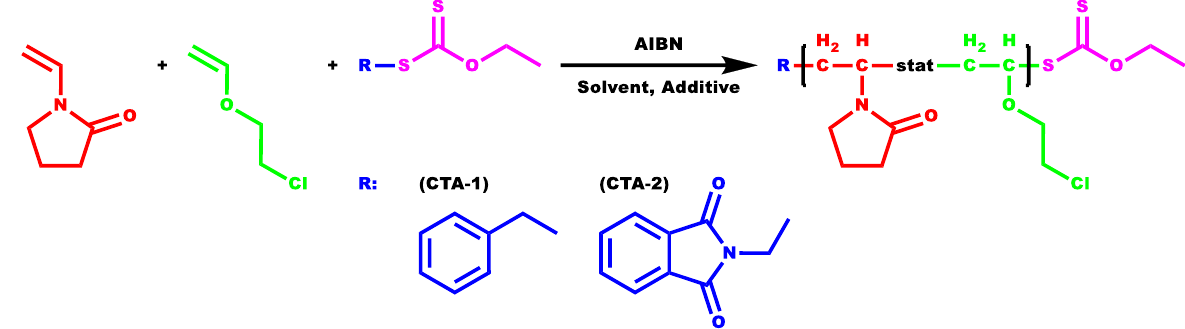
Table 1. Molecular characteristics of statistical copolymers P(NVP – stat – CEVE) via Radical RAFT. Entry